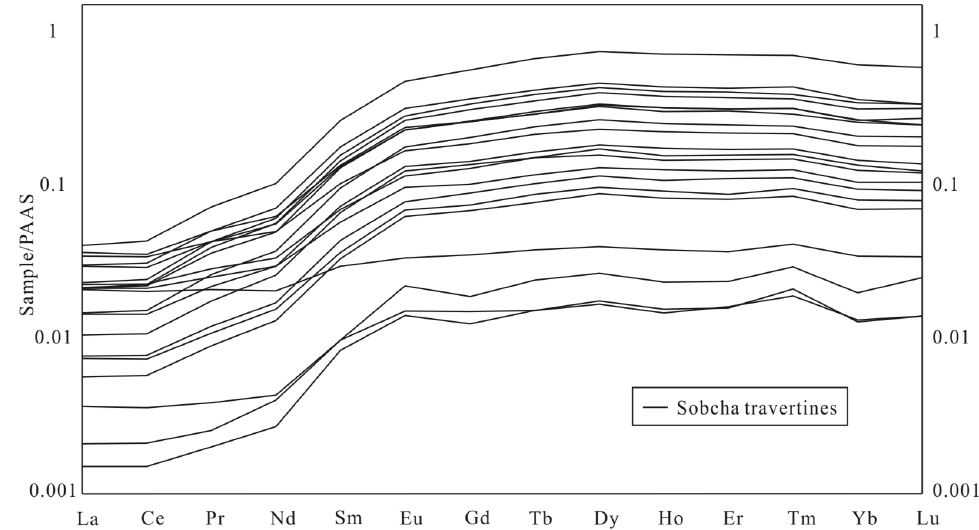
Figure 10. PAAS-normalized REE patterns for the travertine samples of Sobcha.